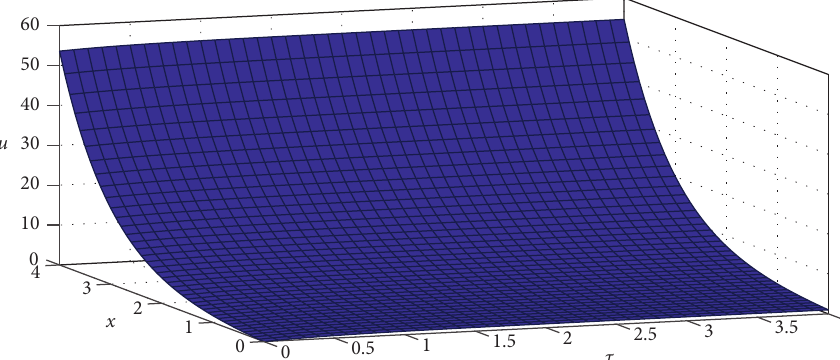
Figure 4: Behavior of the Black–Scholes equation with α �